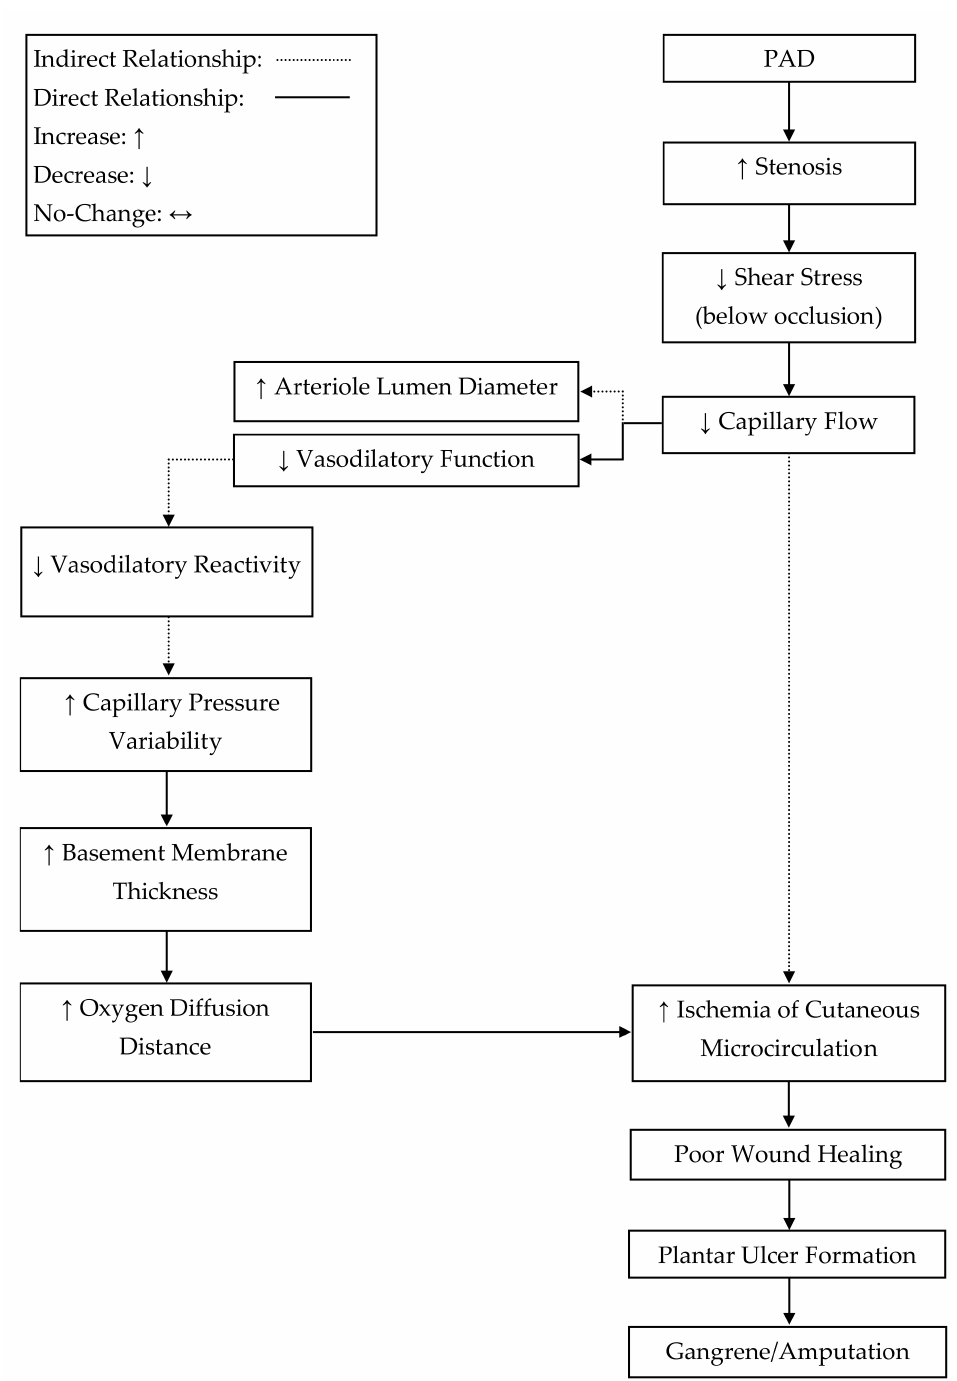
Figure 2. A proposed mechanism for progressive tissue ischemia below an occlusion in peripheral artery disease (PAD). The progressive narrowing of the conduit arteries and the reduced reactivity of arterioles, due to plaque development, may lead to ischemia-related, plantar ulcers and subse- quent